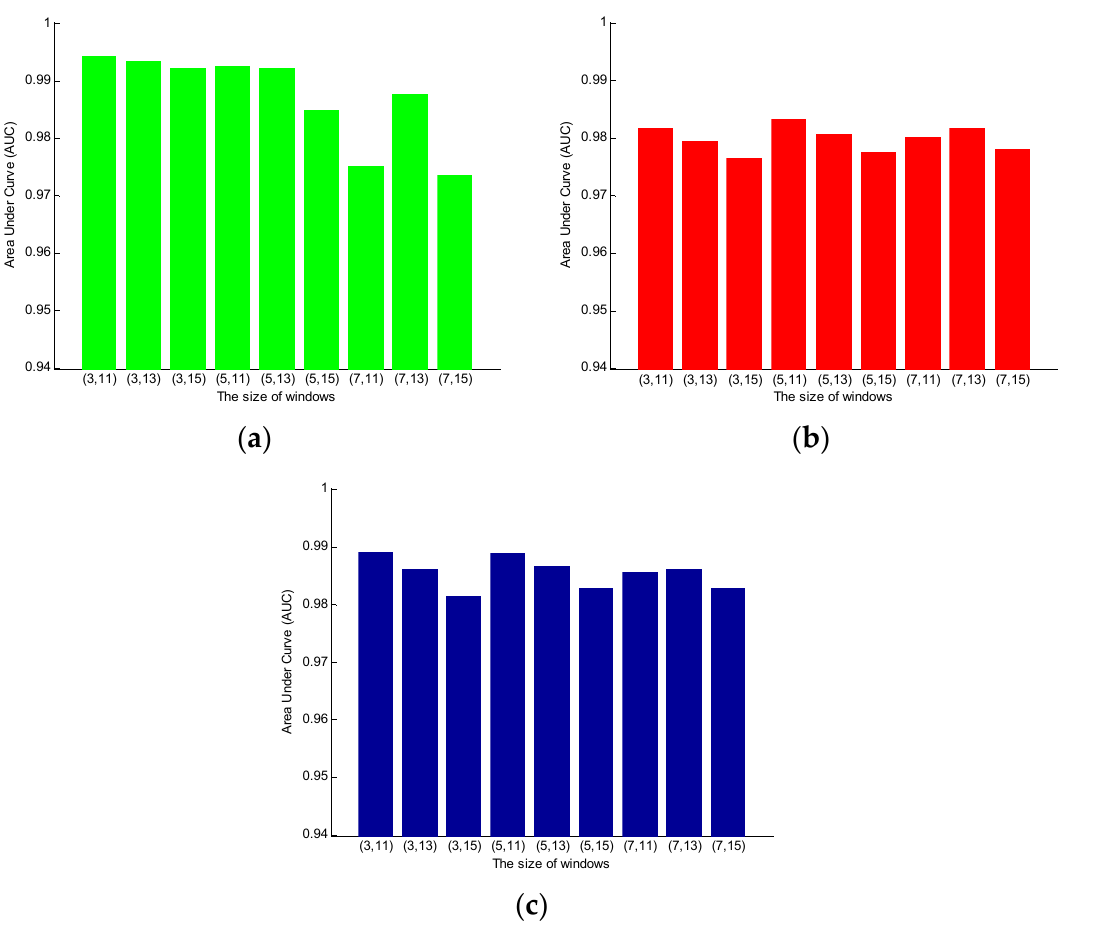
w w . ( a ) Synthetic dataset; ( b ) in out